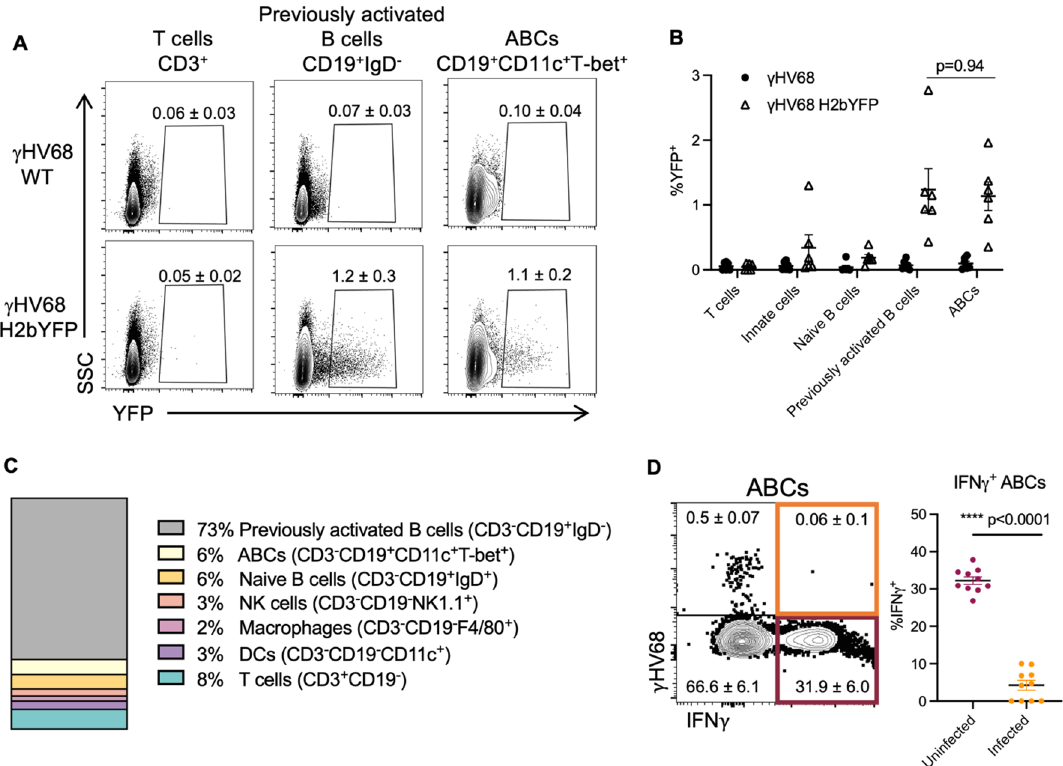
Figure 3. Analysis of ABC infection status with fluorescent γHV68 strain. Female C57BL/6(J) mice (6 to 8-week-old at infection) infected i.p. with γHV68 or γHV68.H2bYFP. 8 days p.i. spleen collected and processed for flow cytometry. ( A ) Representative flow cytometry plots displaying yellow fluorescent protein (YFP) expression (x-axis) versus side-scatter (SSC, y-axis) from mice infected with γHV68 or γHV68.H2bYFP with mean ± SEM. Samples gated on live, single lymphocytes, and then T cells (CD3 + ), total B cells (CD19 + ), previously activated B cells (CD19 + IgD − ), or ABCs (CD19 + CD11c + T-bet + ). Two samples per group concatenated for the purpose of visualization. Representative of two experiments. ( B ) Proportion of cell subsets positive for YFP expression from γHV68-infected mice (filled circles) and γHV68.H2bYFP-infected mice (open triangles). Each data point represents an individual mouse. ( C ) Proportion of YFP + cells that are non-B cells (CD19 − , white), non-ABC B cells (CD19 + CD11c − T-bet − , grey), or ABCs (CD19 + CD11c + T-bet + , black). Data n = 6 mice per group, data compiled from two experiments, representative of three experiments. ( D ) Representative flow plot of ABCs (CD19 + CD11c + T-bet + ) in the spleen gated for YFP (γHV68.H2bYFP) and IFNγ with mean ± SEM. Dot plot displays the proportion of either uninfected (YFP − ) or infected (YFP + ) ABCs in the spleen that